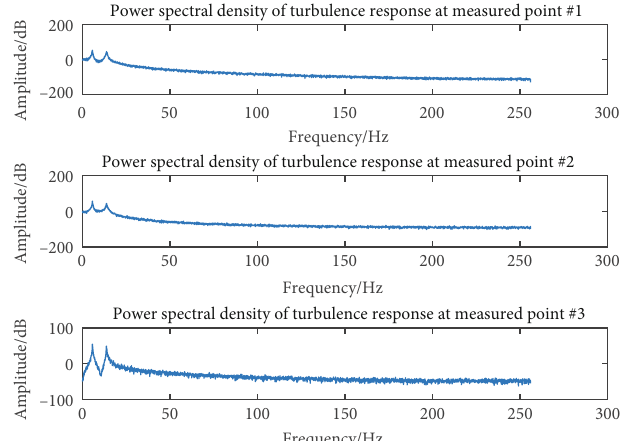
Figure 2: PSD of the two-mode turbulence response.